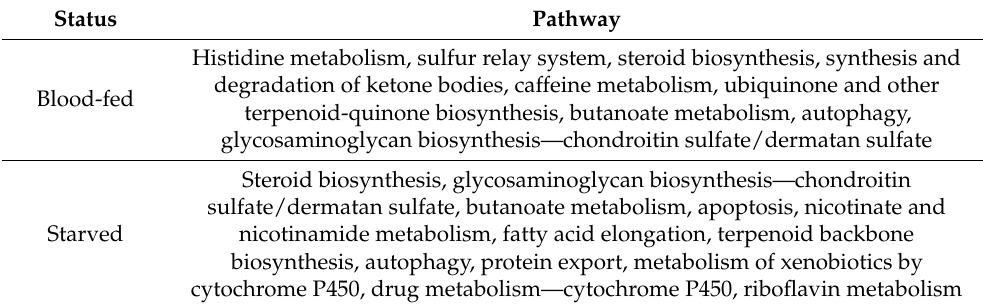
Table 4. KEGG enriched pathways in blood-fed and starved tropical bed